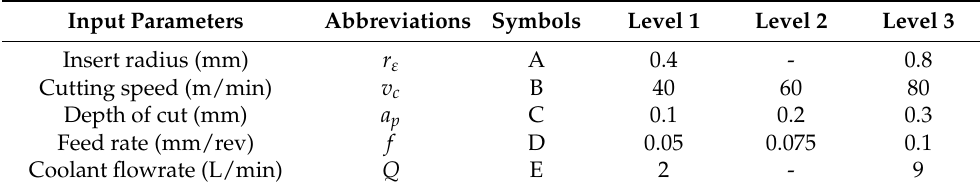
Table 2. Machining parameters and their selected Table 1. EBM parameters employed for specimen fabrication.